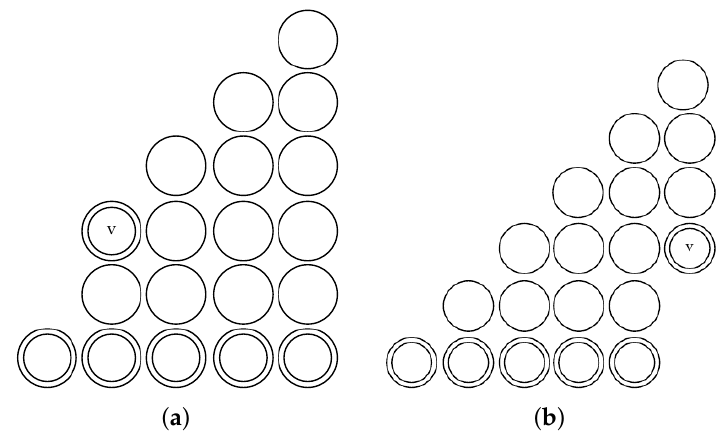
Figure 5. Effect of adding a primary vertex to a pyramid. ( a ) If we add an activated vertex v to the left side of a pyramid, then the vertices in the same diagonal with times greater than the time of v are activated until reaching the top of the pyramid. ( b ) If we add an activated vertex v to the right side of the pyramid, then the vertices in the same column with a time greater than the time of v are activated until reaching the top of the